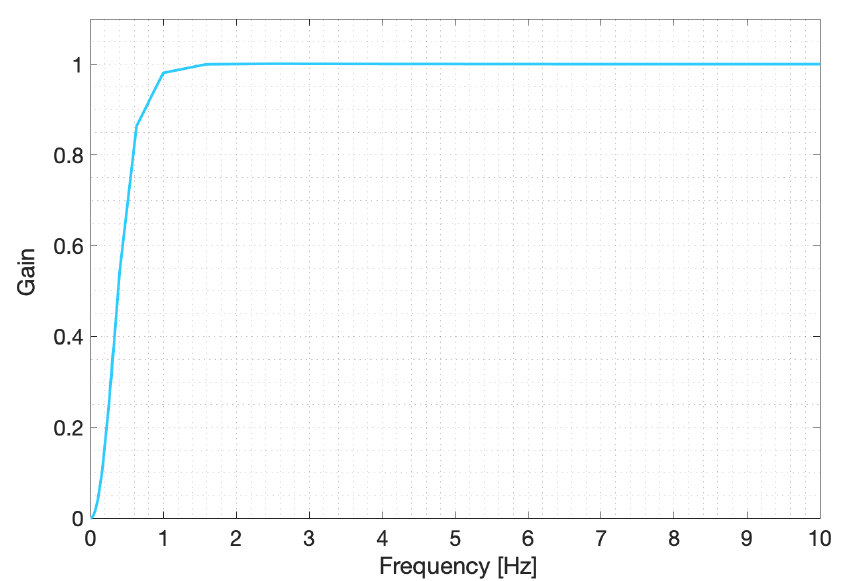
Figure 6. Magnitude response for the high-pass filter. The plot shows the filter’s gain for different sinusoidal inputs frequencies. The filter is configured to reject frequencies lower than f c = 0.5